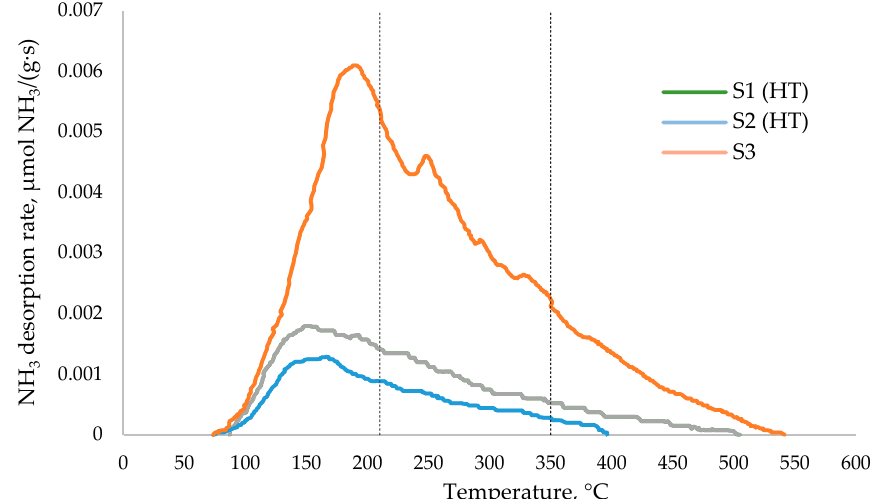
Figure 5. Curves of the temperature-programmed desorption (TPD) of ammonia of samples (HT-heat treated).